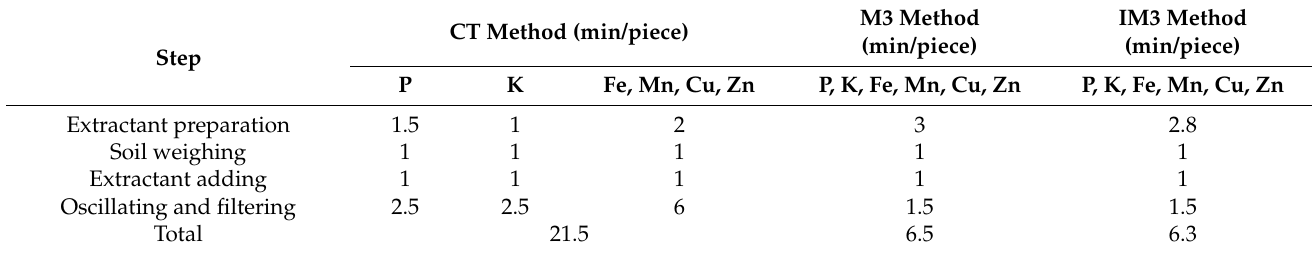
Figure 4. The variation coefficient of soil available in P, K, Fe, Mn, Cu and Zn determined by three test methods. Note: A, B and C indicated CT method, M3 method and IM3 method, respectively. The different letters of a, b and c indicated the significance at p < 0.05. Table 3. The comparison of testing time among three test methods.